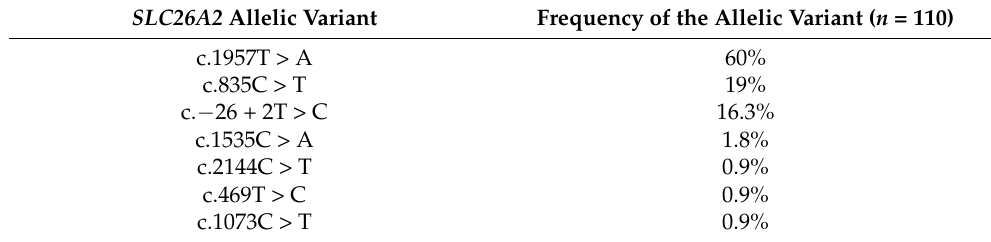
Table 3. Frequency of the allelic variants in the SLC26A2 gene in patients with MED type 4.